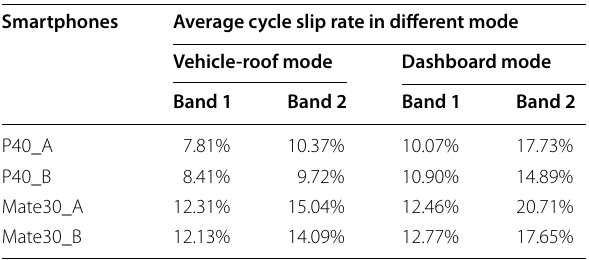
Table 4 Statistic results on the average cycle slip rate of the dual-frequency carrier phase measurements of the experimental smartphones in the vehicle-roof mode and dashboard mode Smartphones